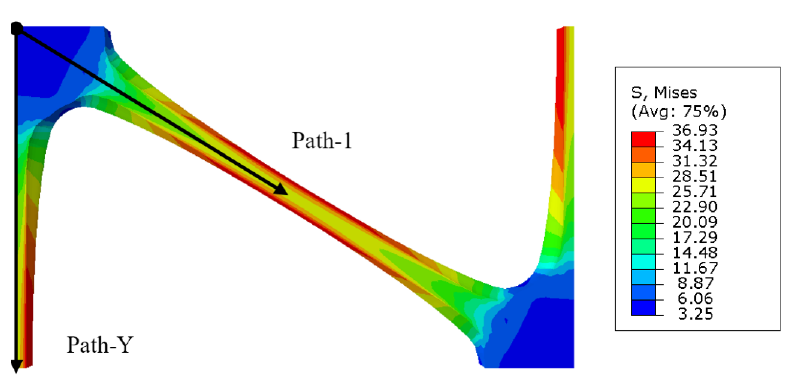
Figure 16. Cross section of the thick symmetry axis and path definition of triaxial geogrid.